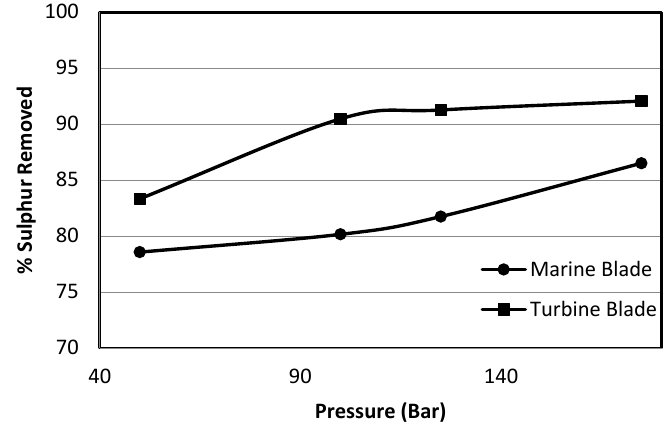
Figure 5. Comparison of Marine Blade vs. Turbine Blade agitation on the basis of pyritic sulphur removal.